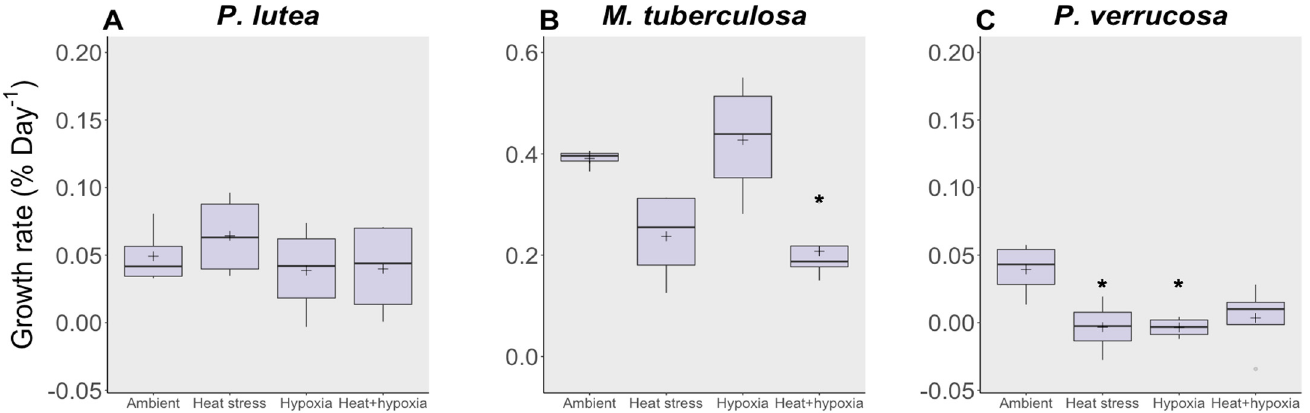
Figure 7. Growth rates of P. lutea ( A ), M. tuberculosa ( B ), and P. verrucosa ( C ) under ambient, heat stress, hypoxia, and heat stress + hypoxia. Data are shown as mean (+), median, and range ( n = 4) in a boxplot, where an asterisk indicates statistical significance of treatment when compared to ambient.